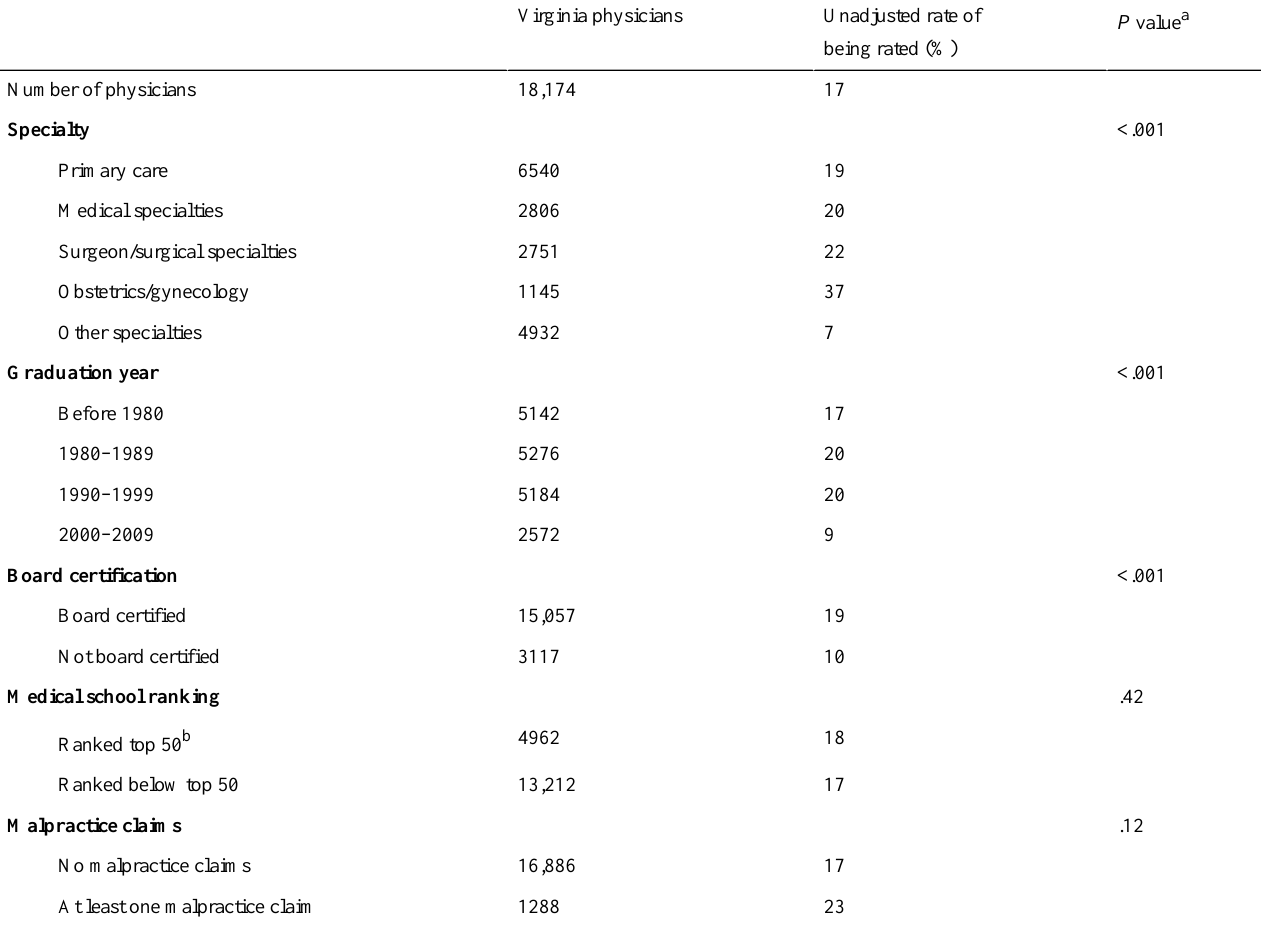
Table 2. Virginia physicians by quality rating status.